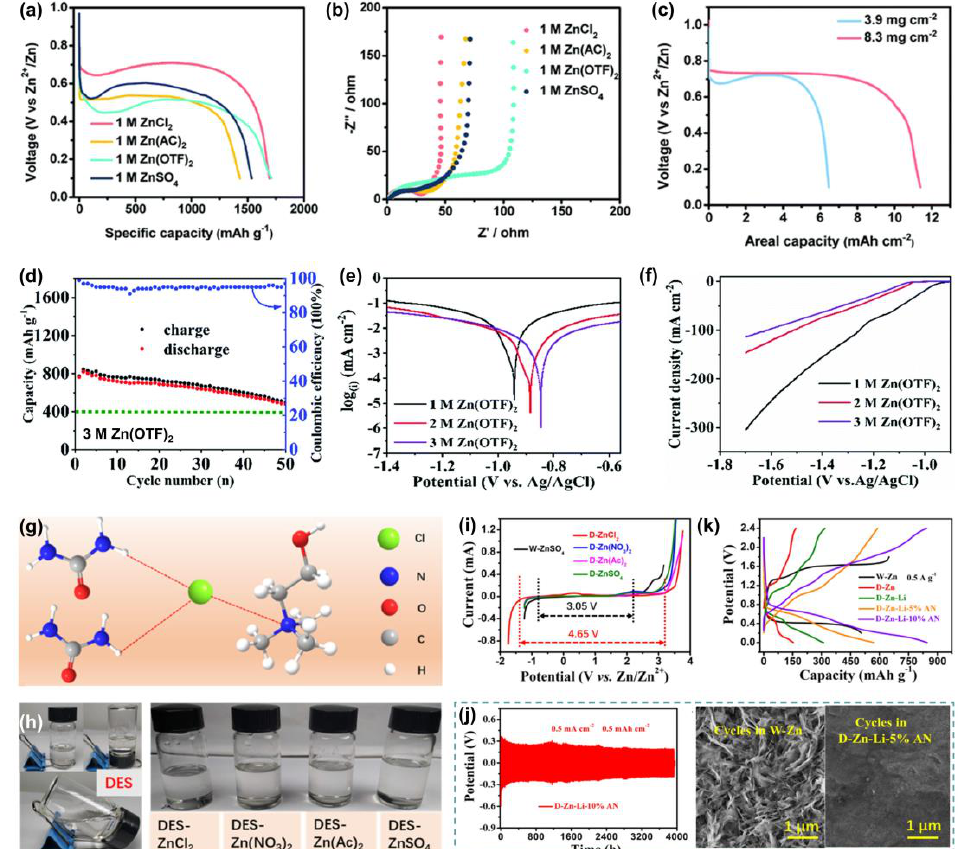
Figure 3. ( a ) Discharge curves and ( b ) electrochemical impedance spectroscopy (EIS) spectra of AZSBs using different electrolytes; ( c ) discharge curves with different S mass-loading of AZSBs (reproduced with permission from Ref. [80]. Copyright 2021, Royal Society of Chemistry). ( d ) Cycling performance of AZSBs at 200 mA g − 1 in 3 M Zn(OTF) 2 electrolyte, ( e ) corrosion potentials and ( f ) LSV curves of Zn anodes in the Zn(OTF) 2 electrolyte with different concentrations (reproduced with permission from Ref. [64]. Copyright 2022, Royal Society of Chemistry). ( g ) Illustration of the ChCl/urea DES; ( h ) different Zn salts dissolved in the DES; ( i ) electrochemical windows of AZSBs in different electrolytes; ( j ) cycling test of the Zn symmetrical cell in DES-based electrolyte, and scanning electron microscopy (SEM) images of different Zn anodes; ( k ) galvanostatic charge − discharge (GCD) curves of AZSBs in different electrolytes (reproduced with permission from Ref. [83]. Copyright 2021, American Chemical